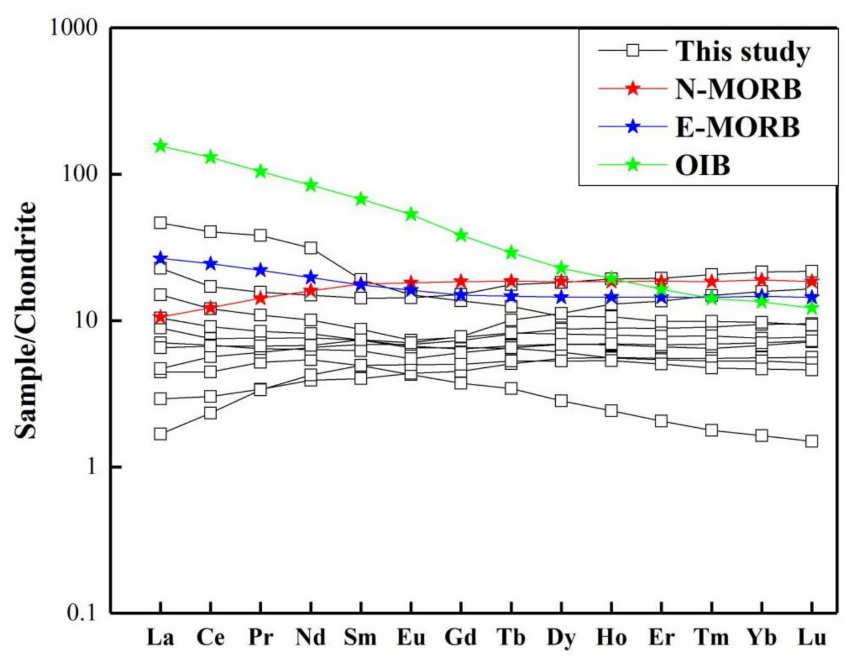
Figure 5. Primitive mantle-normalized trace element patterns of the Hannuoba websterite xenoliths. Note: Paleozoic garnet pyroxenite represents the pyroxenite with the origin of melt crystallization [41]; Mesozoic wehrlite represents the pyroxenite formed by the interaction between peridotite and the melt from recycled continental crust materials [42]; Cenozoic composite pyroxenite represents the pyroxenite by peridotite-melt interaction [38]; Data of primitive mantle, normal mid ocean ridge basalt (N-MORB), enriched mid ocean ridge basalt (E-MORB) and ocean island basalt (OIB) are sourced from Sun and McDonough [43].